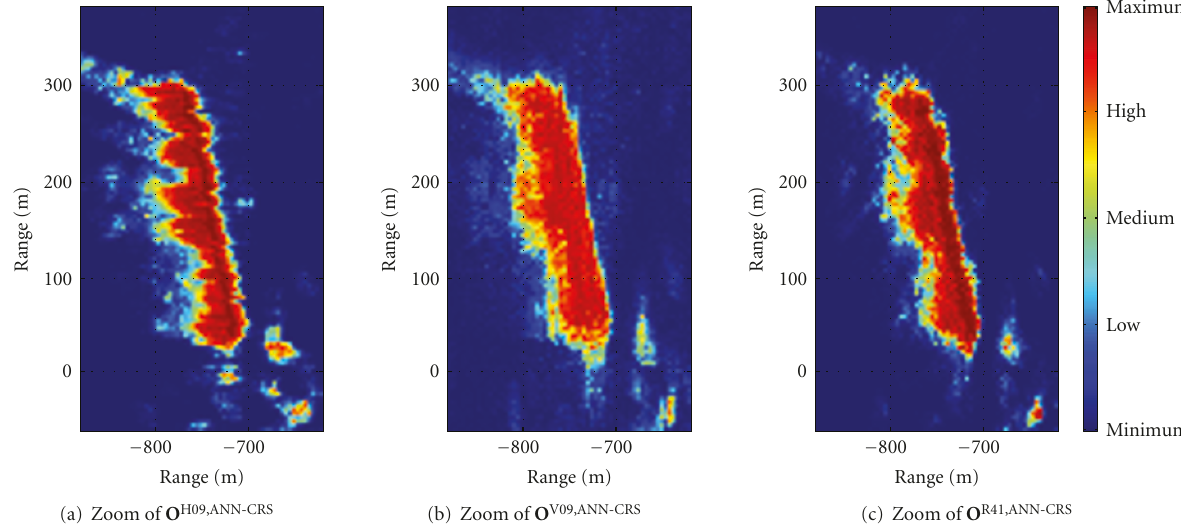
Figure 9: Zoom of the Images Processed by the ANN-based Clutter Reduction System Using its Best H, V, and R Integration Modes.